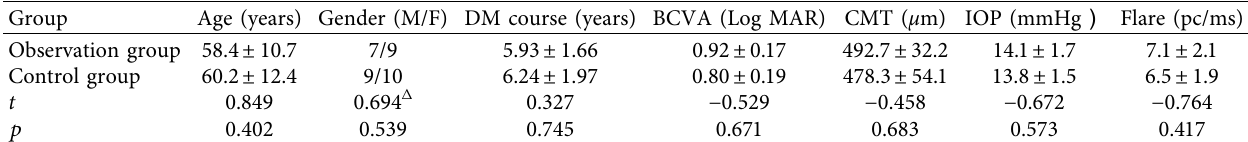
Table 1: Demographic profile and baseline characteristics of the patients.